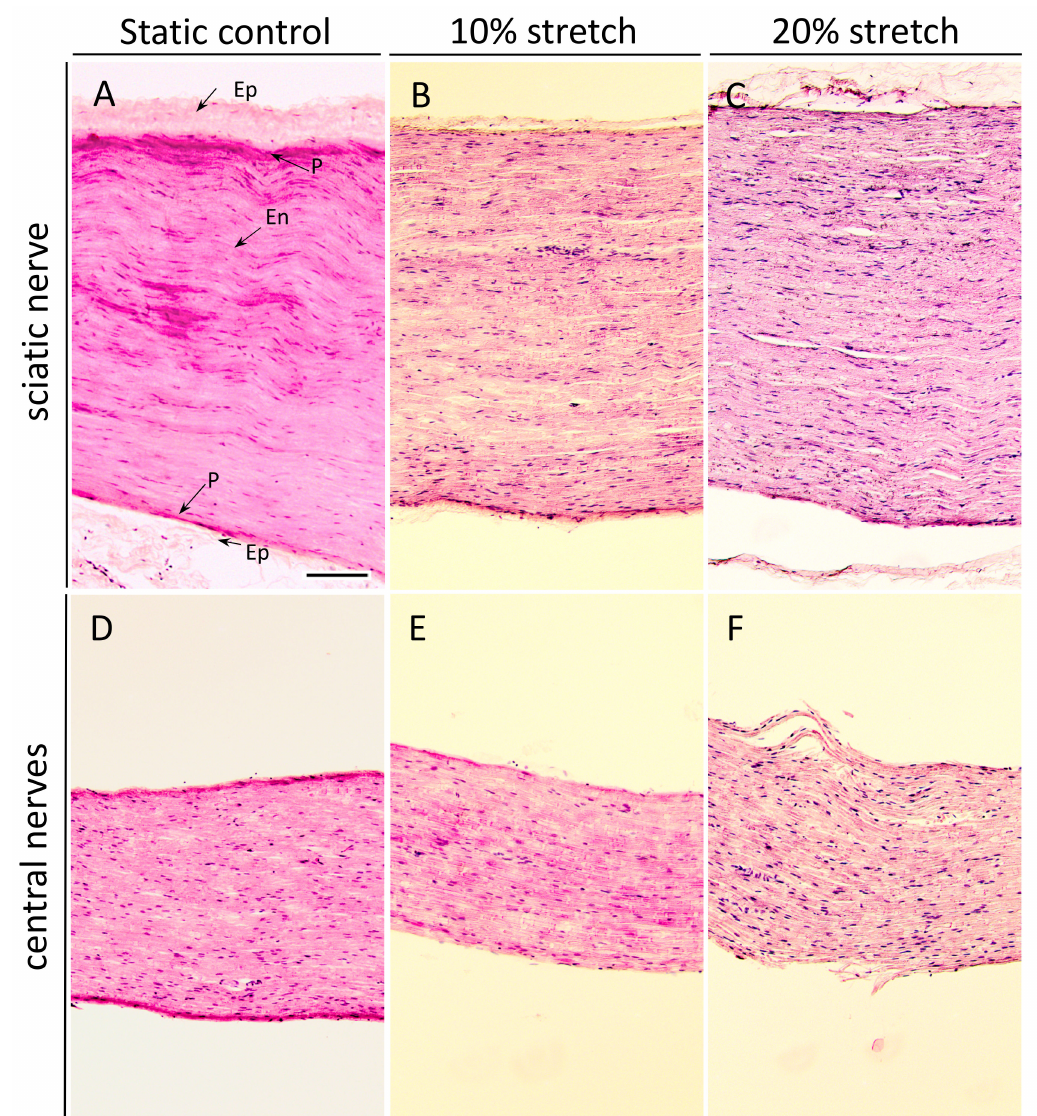
Figure 5. 3 h of 10% stretch does not significantly alter the microarchitecture of the nerve, although 20% stretch does. ( A – F ) Photomicrographs (10 × ) of H&E staining of sciatic nerves ( A – C ) and central nerves ( D – F ). Nerves were fixed and dissected longitudinally after either no stretch ( A , D ) or mechanical loading of 10% ( B , E ) or 20% ( C , F ). Arrows in ( A ) indicate the epineurium (Ep), perineurium (P), and endoneurium (En). The epineurium, specific to the PNS, is densely formed in the static controls but begins to unravel upon 20% stretch. The perineurium, a protective sheath covering nerve fascicles, was found to slowly thin with increasing amounts of stretch, with some tears in the 20% samples. Notably, the naturally occurring nerve undulation observed in the static control (Bands of Fontana) is progressively lost upon the mechanical stretch. Scale bar, 500 µ